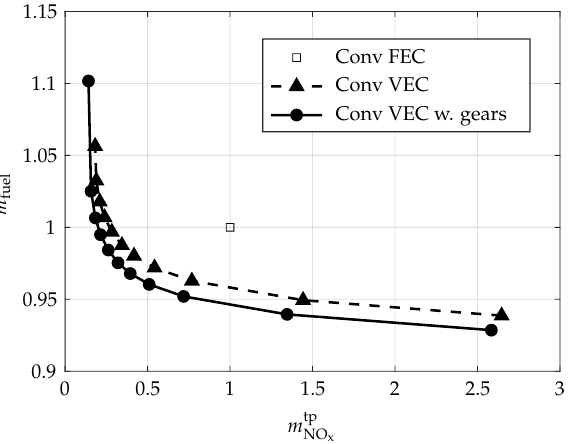
Figure 9. Trade-off between fuel consumption and emitted tailpipe NO x on the WLTC with an initial ATS temperature below the light-off temperature. The markers represent individual DP optimizations for specific values of µ . All values were